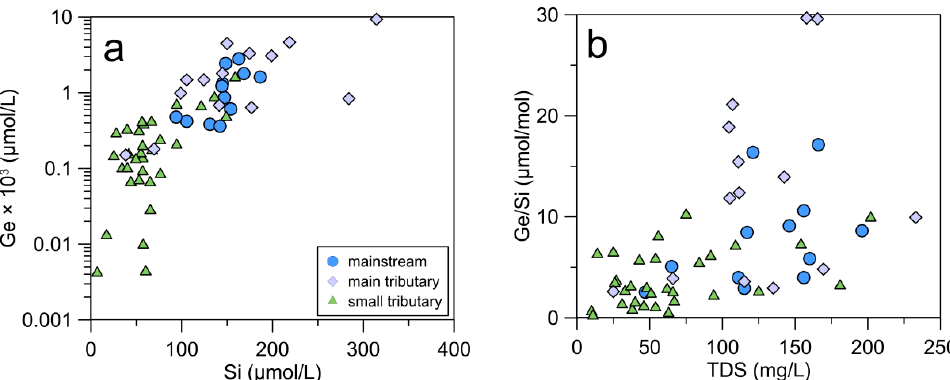
Figure 5. Relations between Si and Ge ( a ) and TDS and Ge/Si ratio ( b ) of river water.